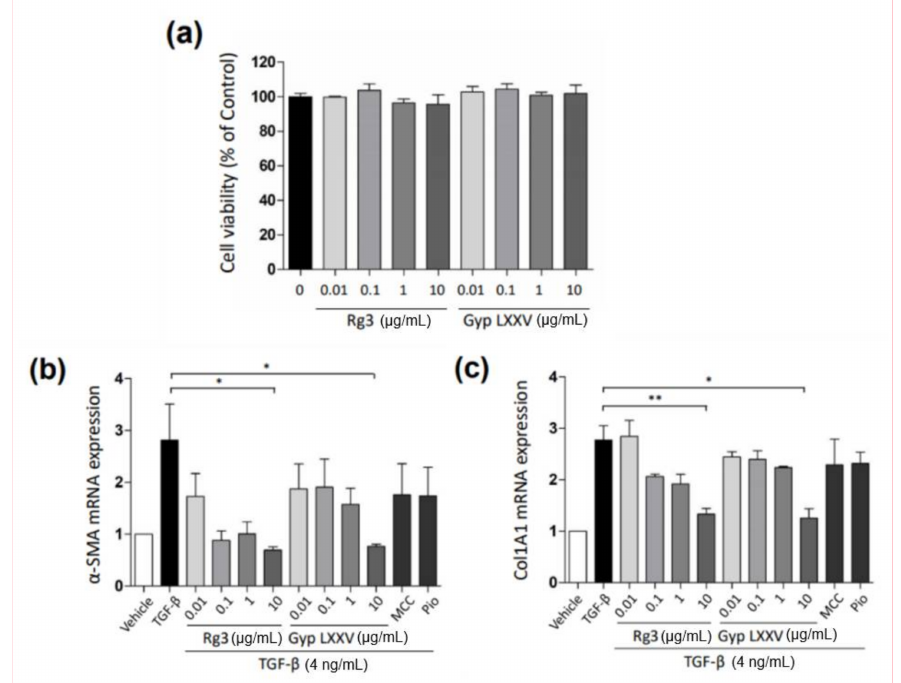
Figure 1. E ff ect of gypenoside LXXV (Gyp LXXV) on cell viability and fibrosis in hepatic stellate cells (LX-2). Cell viability of Gyp LXXV or Rg3 on LX-2 cells ( a ). Cells were treated with increasing concentrations of Gyp LXXV or Rg3 (0.01–10 µ g / mL) for 24 h. Gyp LXXV-mediated inhibition of fibrosis markers, α -smooth muscle actin ( α -SMA) ( b ) and collagen1 ( c ), via transforming growth factors- β (TGF- β ) (4 ng / mL)-induced LX-2 activation (n = 3 for each group). * p < 0.05, ** p < 0.01 vs. TGF- β . MCC950 (MCC; 1 µ M) or pioglitazone (Pio; 10 µ M) was used as positive